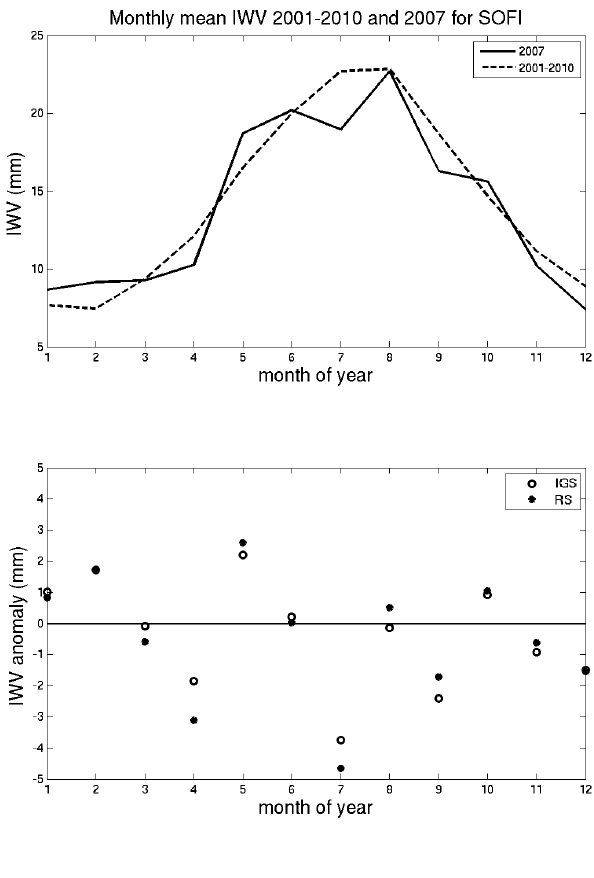
Figure 7. Top figure: monthly mean IWV for SOFI, Bulgaria (thick line 2007, dashed line 2001–2010). Bottom figure: monthly anomaly (difference 2007 mean and 2001–2010 mean) from GNSS (open circles) and radiosonde (filled circles).